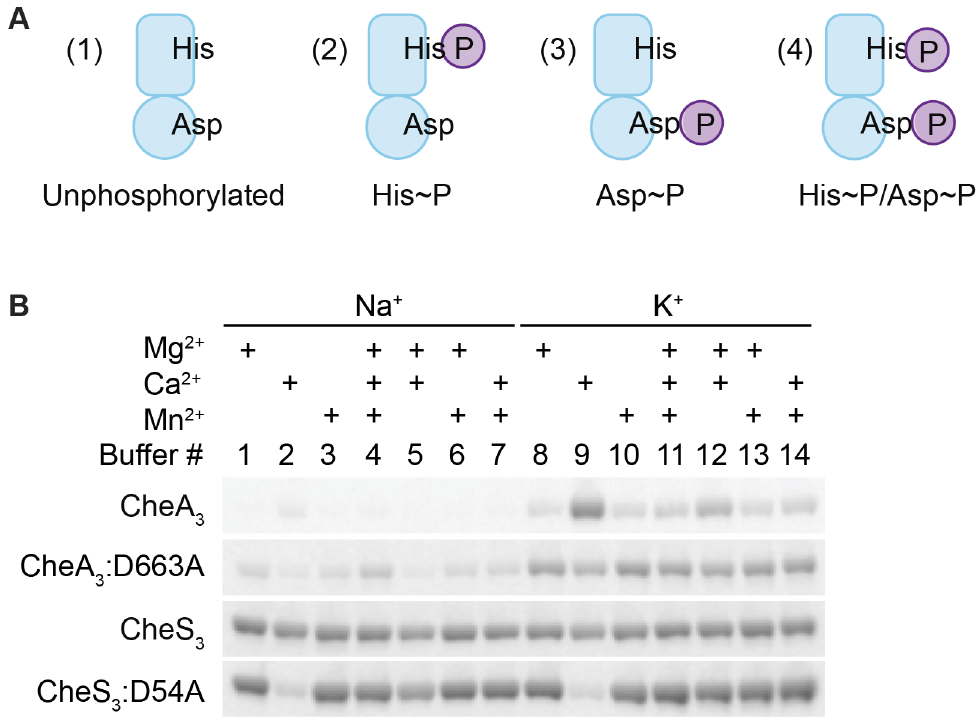
Figure 3. Metal ion dependent phosphorylation of CheA 3 and CheS 3 . (A) Four possible phosphorylation states of phosphorylated hybrid histidine kinases (HHKs). (B) Metal cation dependencies of phosphorylation of isolated HHKs CheS 3 and CheA 3 and their receiver domain